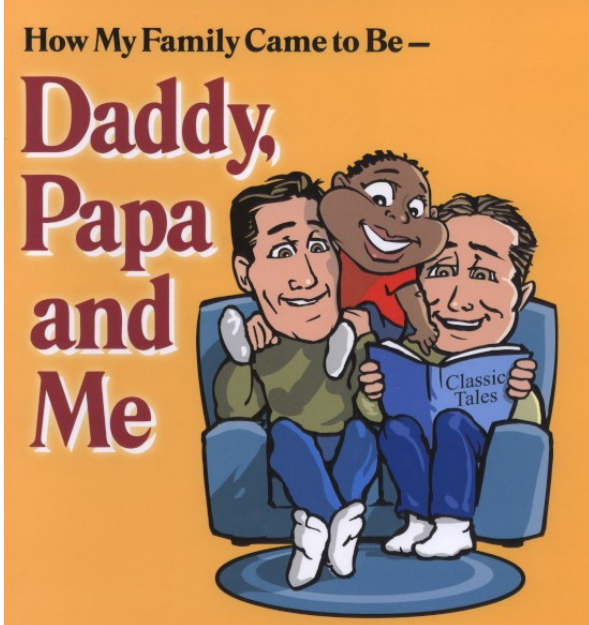
Figure 2. The cover as the first step in a demand for familial recognition. (Detail from the cover of Andrew Aldrich’s autobiographical picture book).